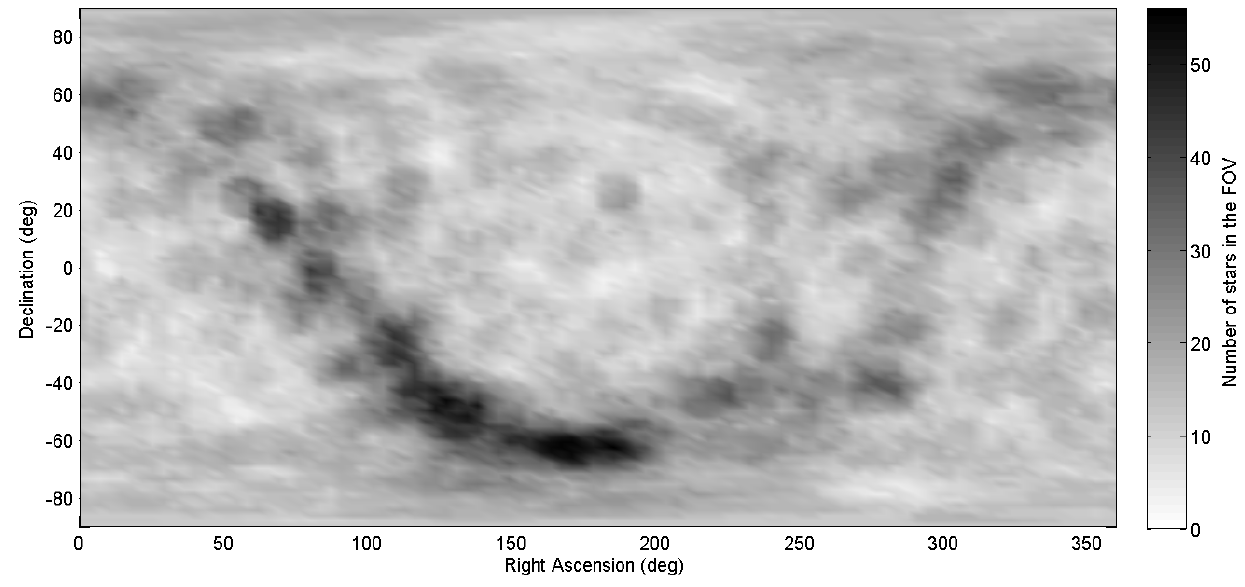
Figure 4. ST-16 spatial static star distribution map (0 deg/s).